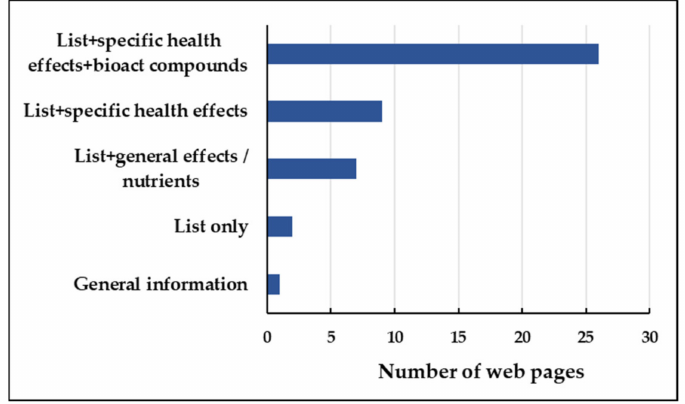
Figure 3. Number of selected web pages that provided different types of information.